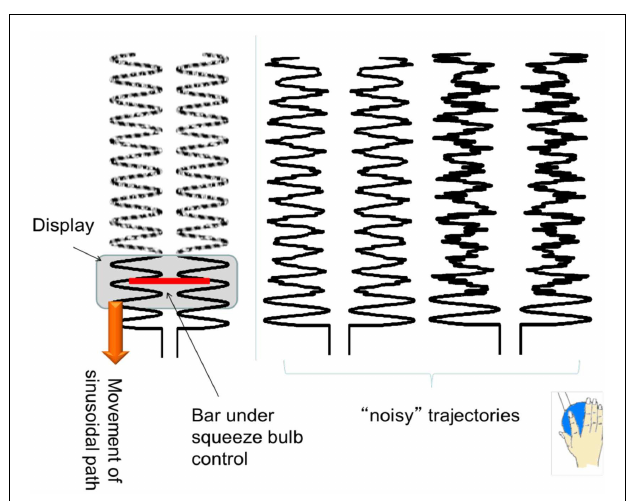
FIGURE 1 |An illustration of the experimental task .The sinusoidal path scrolls down vertically, with different frequencies of noise trajectories. Subjects had to control the width of the (red) bar to maintain the ends of the bar within the sinusoidal